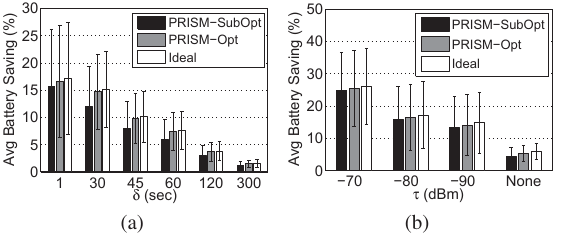
Figure 11: Mean battery savings for all users in the dataset with 95% confidence interval. (a) vary δ given τ = − 80 dBm, (b) vary τ given δ = 1 sec. uously and during the time slots (e.g., δ = 30 sec , 45 sec .. 5 min ), only 20 sec of time slot is utilized for sensing operations and the Wi-Fi radio is turned OFF for remaining time. Email sync applica- tions are shown to take close to 18 . 54 sec [32]. Hence, we